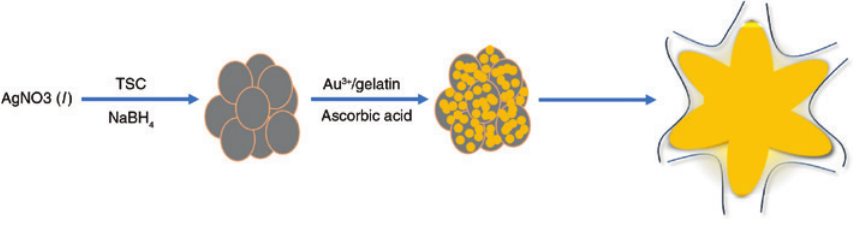
Figure 1: Schematic illustration of the preparation of star-shaped Ag@Au@gelatin